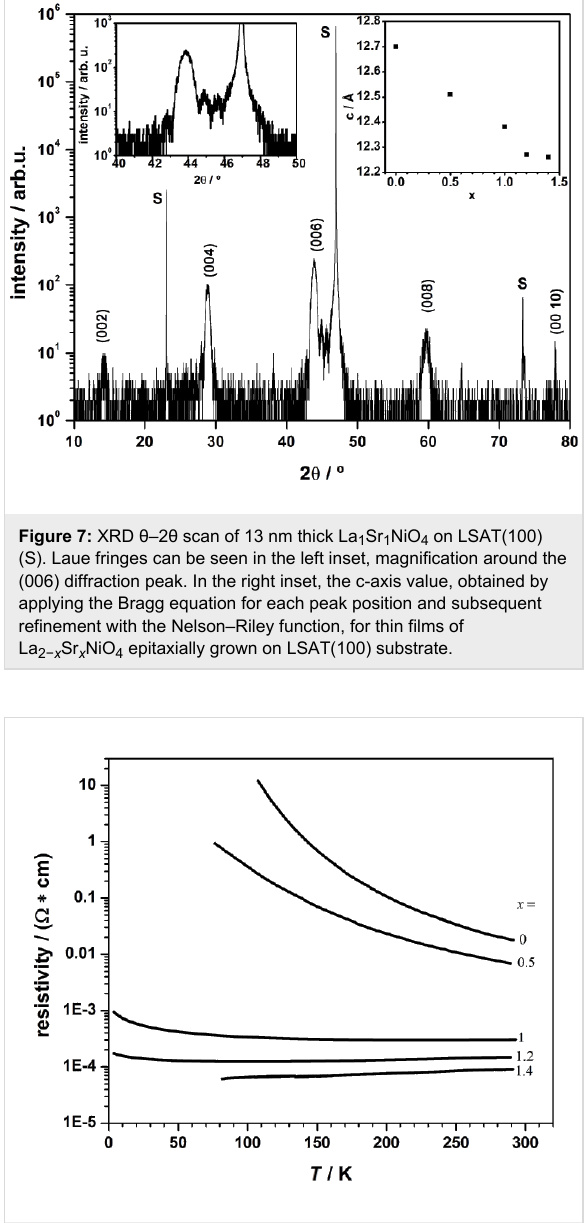
Figure 8: Resistivity versus temperature for La 2 − x Sr x NiO 4 with different doping